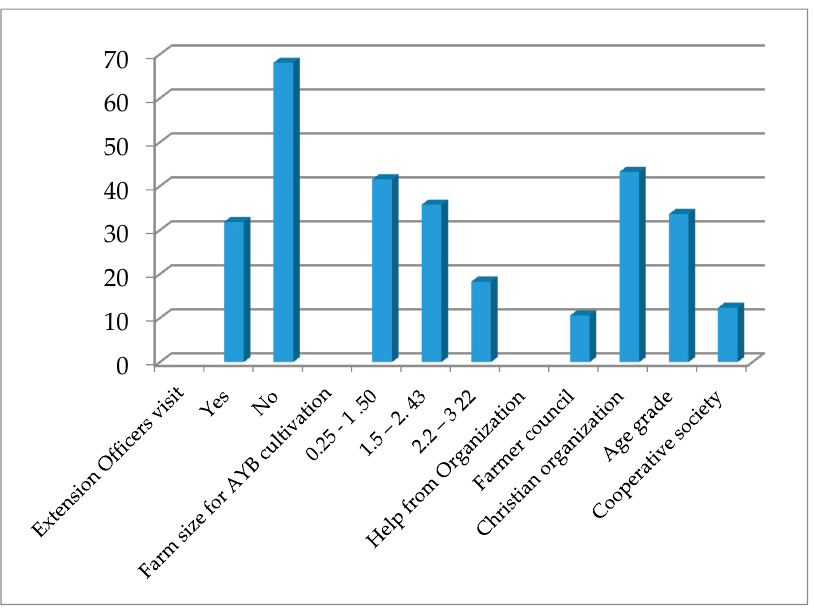
Figure 4. Extension officer’s visits, size of farmland and source of help for farming activities for respondents in the five states of southeastern, Nigeria.